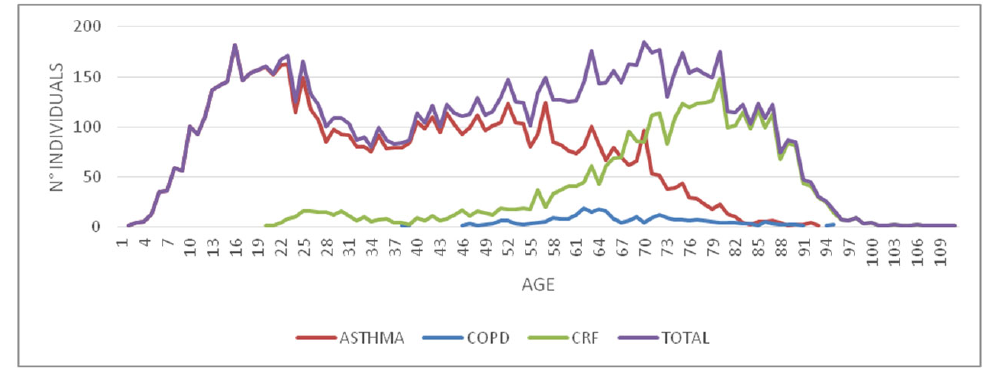
Figure 1. Age distribution of individuals with a chronic respiratory disease (CRD) according to the Local Health Authority (ASL) of Lecce between 2017 and